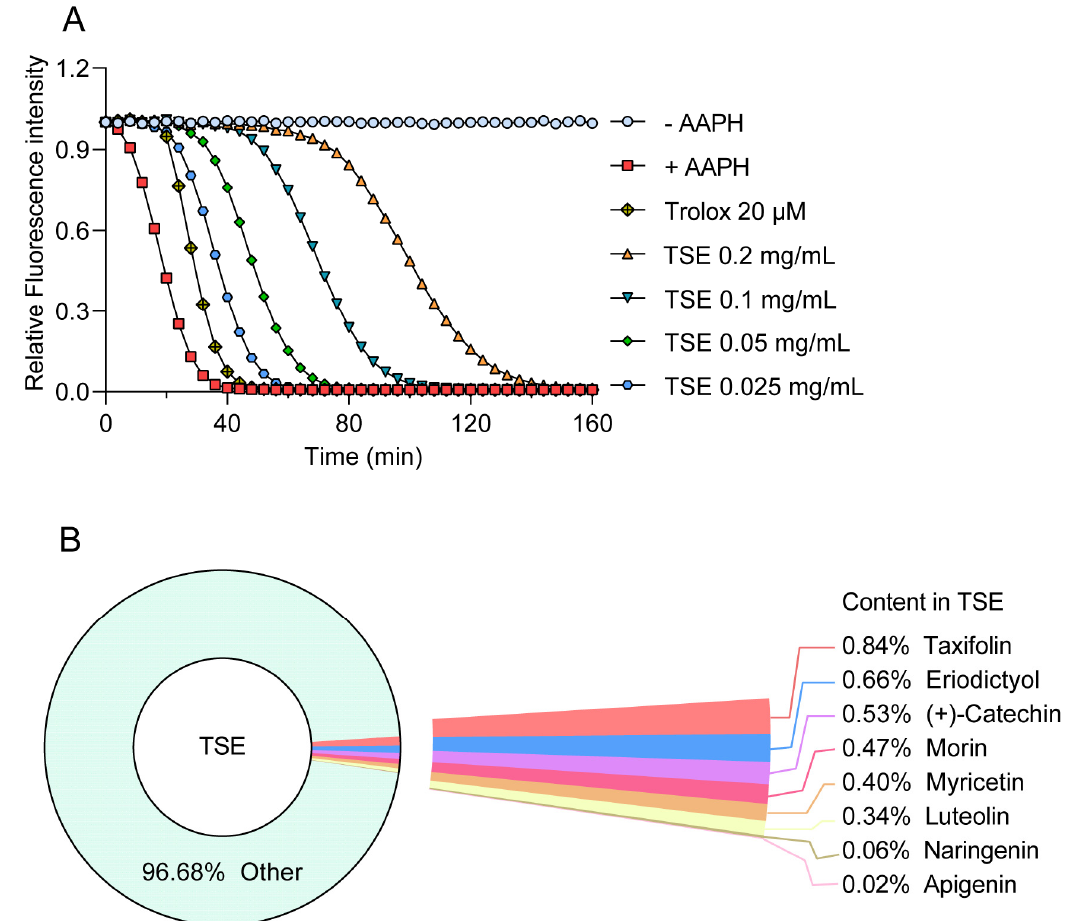
Figure 1. Antioxidant capacity of TSE in vitro evaluated by the ORAC assay. ( A ) The fluorescence attenuation curve of TSE. n = 6. ( B ) The contents of 8 flavonoids in TSE.